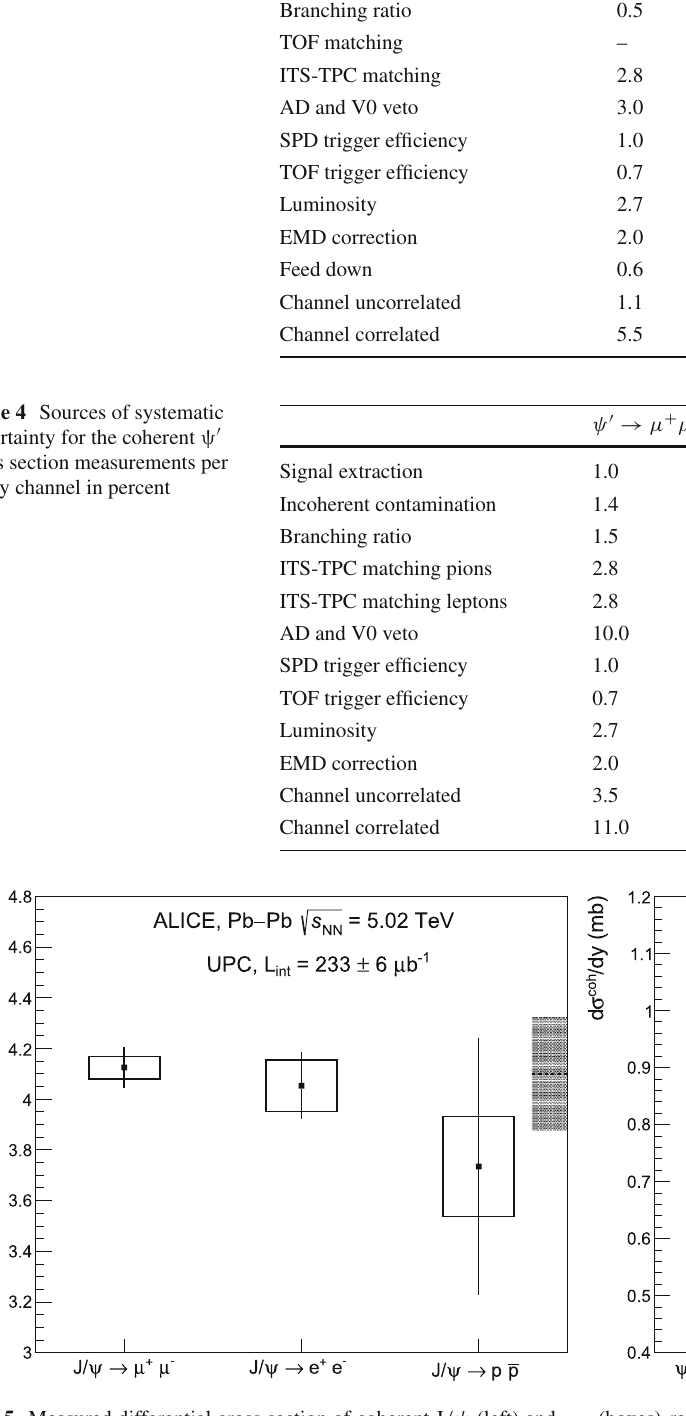
(boxes) represent the statistical (decay channel uncorrelated system- atic) uncertainty. The gray box shows the average value (dashed line) and correlated systematic